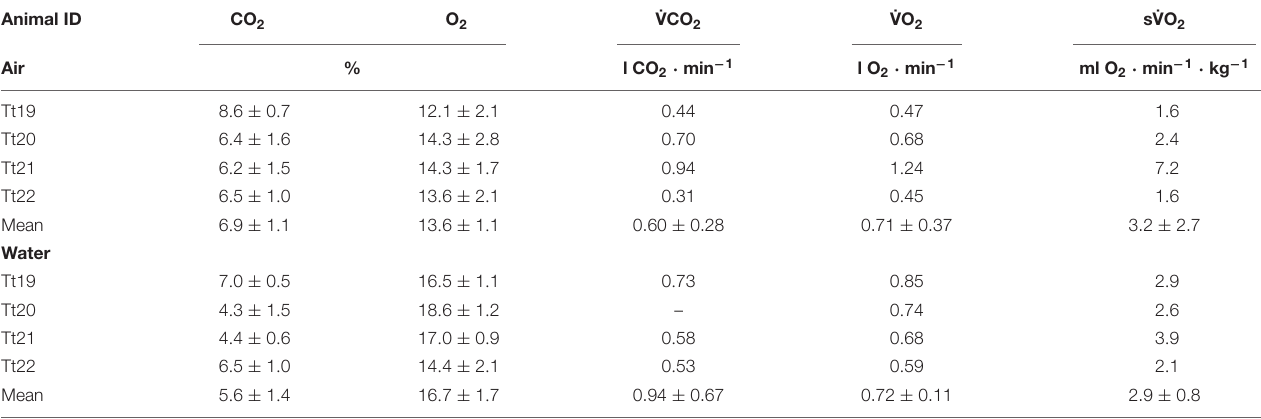
TABLE 3 | Animal ID, end-expired CO 2 and O 2 , CO 2 production rate (˙VCO 2 ), O 2 consumption rate (˙VO 2 ), and mass-specific ˙VO 2 (s˙VO 2 ) while in air or in water. Animal ID CO 2 O